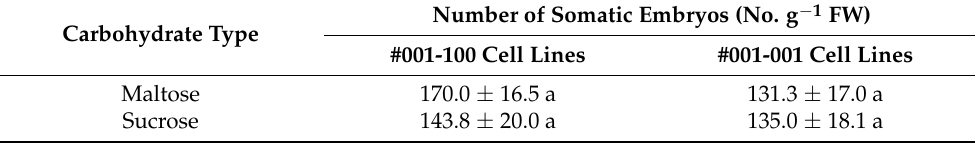
Table 8. E ff ects of maltose and sucrose on the development and maturation of Korean pine somatic Table 8. Effects of maltose and sucrose on the development and maturation of Korean pine embryos. somatic